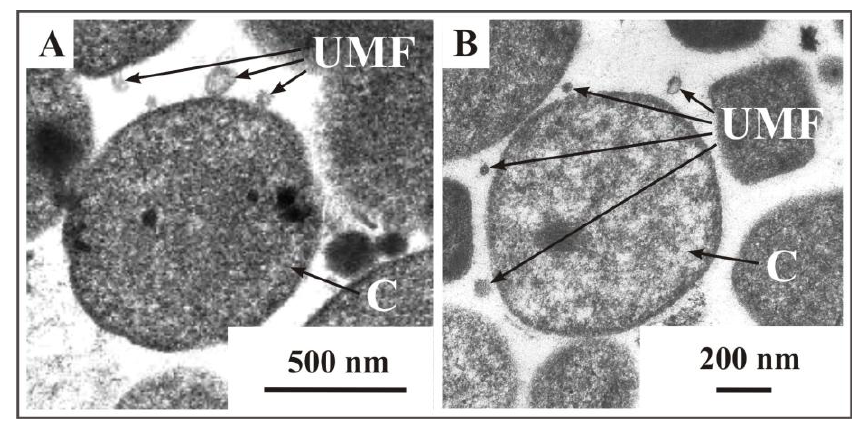
FIGURE 3. Cells and ultramicroforms of A. laidlawii PG8. C = “typical” mycoplasma cells; UMF = ultramicroforms.